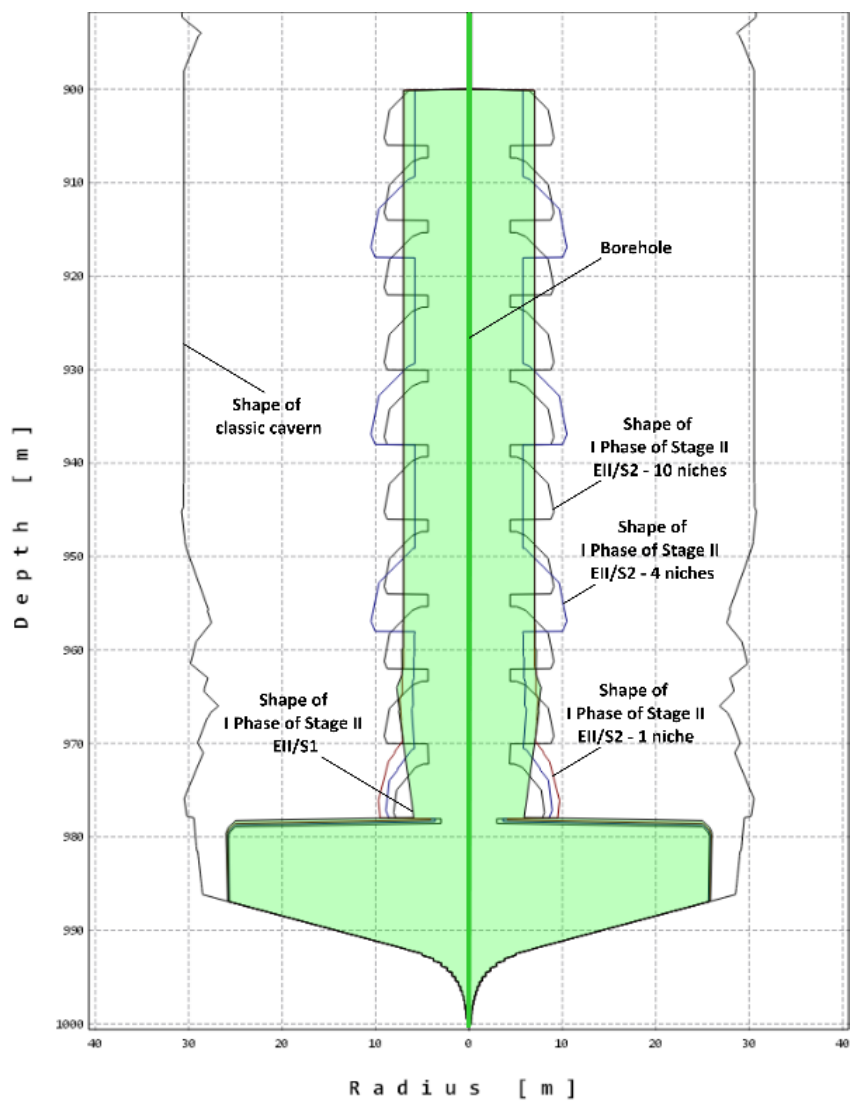
Figure 15. Comparison of the shapes of the I phase of stage II for scenarios on the basis of a classic storage cavern.